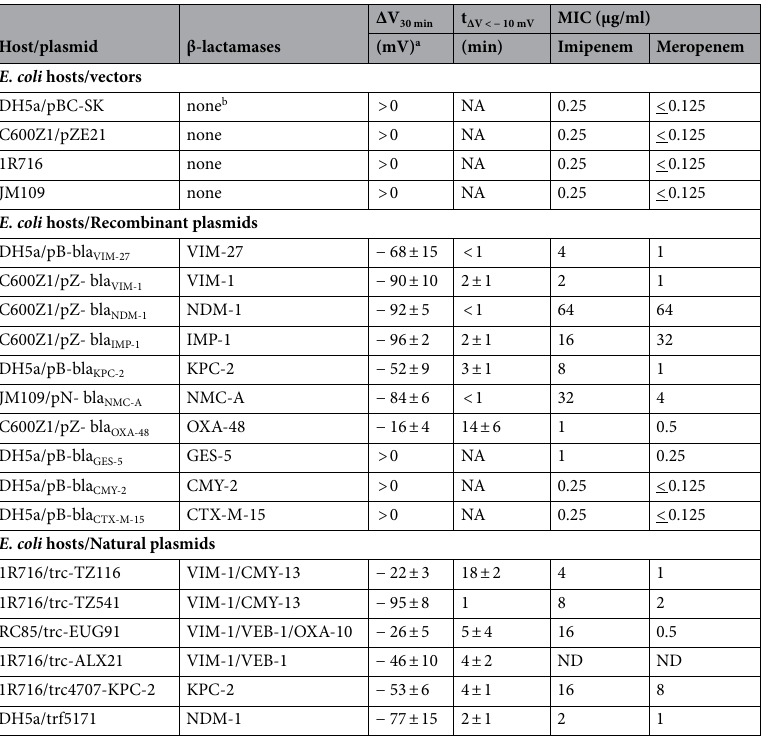
Table 2. ISFET detection of imipenem hydrolysis by laboratory generated E. coli clones. a Means of three measurements are shown ± standard deviations. b E. coli hosts carried the chromosomal class C β-lactamase expressed at basal levels. ND: Not determined, NA: Not